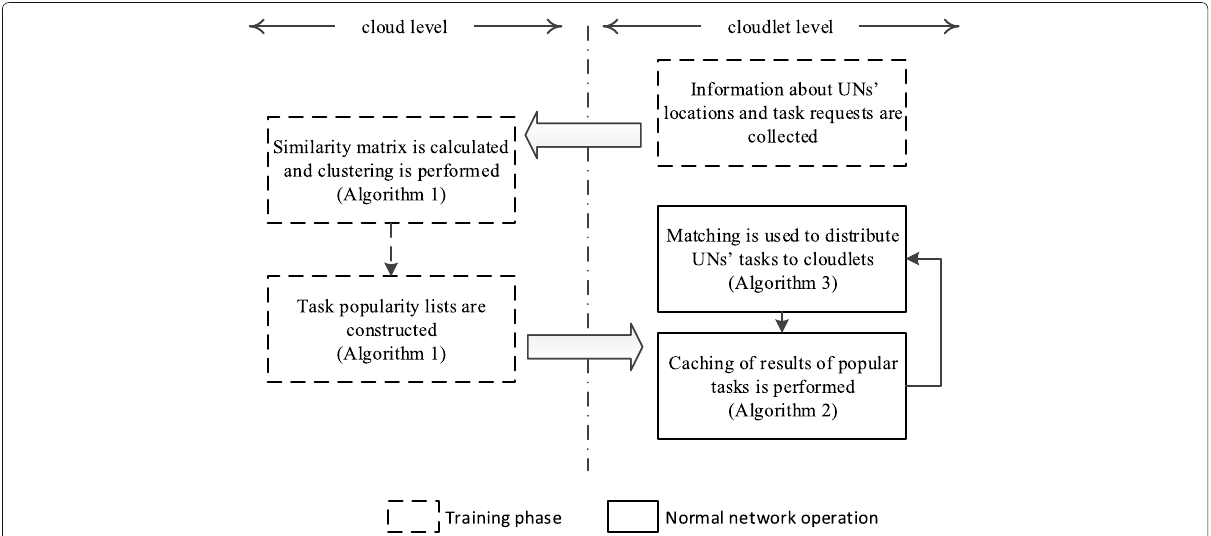
Fig. 2 The proposed approach architecture. The architecture of the proactive edge computing framework